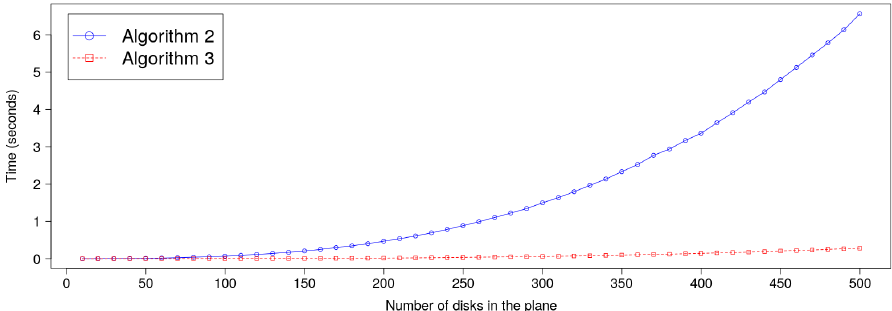
Figure 7. Average time of the script Cech.scale